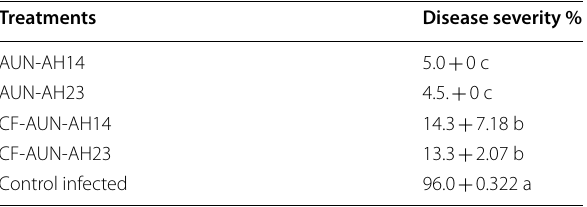
Values within the same column that are associated with different letters indicate significant differences ( P 0.05). Four replicates were used in this ≤